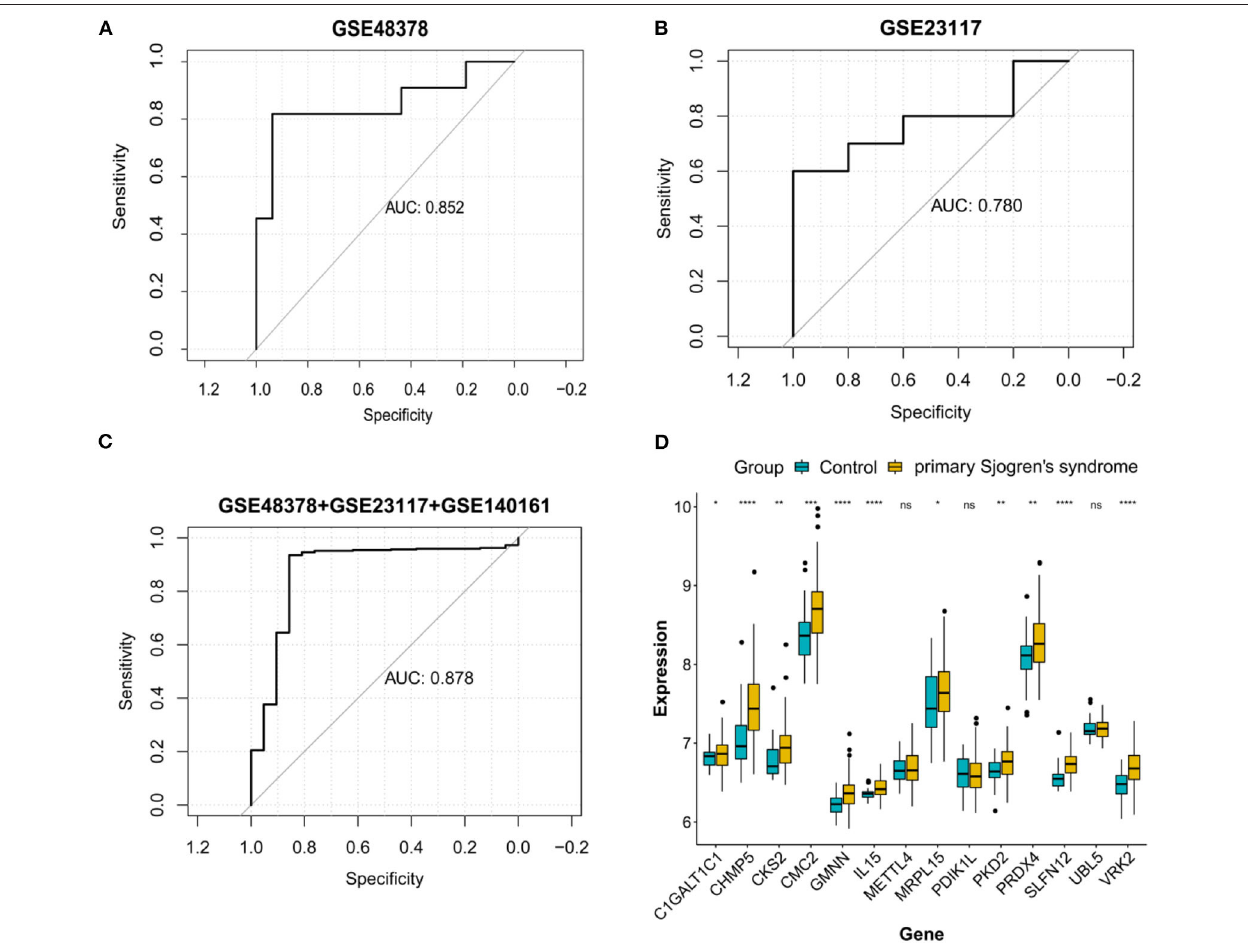
FIGURE 7 | Validation analysis in the Gene Expression Omnibus (GEO) datasets. Receiver operating characteristic curve for the feature genes in the GSE48378 dataset (A) , GSE23117 dataset (B) , and GSE48378 + GSE23117 + GSE140161 datasets (C) . (D) The expression level of the 14 feature genes in the GSE48378 dataset. The blue strip represents the normal control group and the yellow strip represents the primary Sjögren’s syndrome (pSS) group. * P < 0.05; ** P < 0.01; *** P < 0.001; ns indicates with no statistical